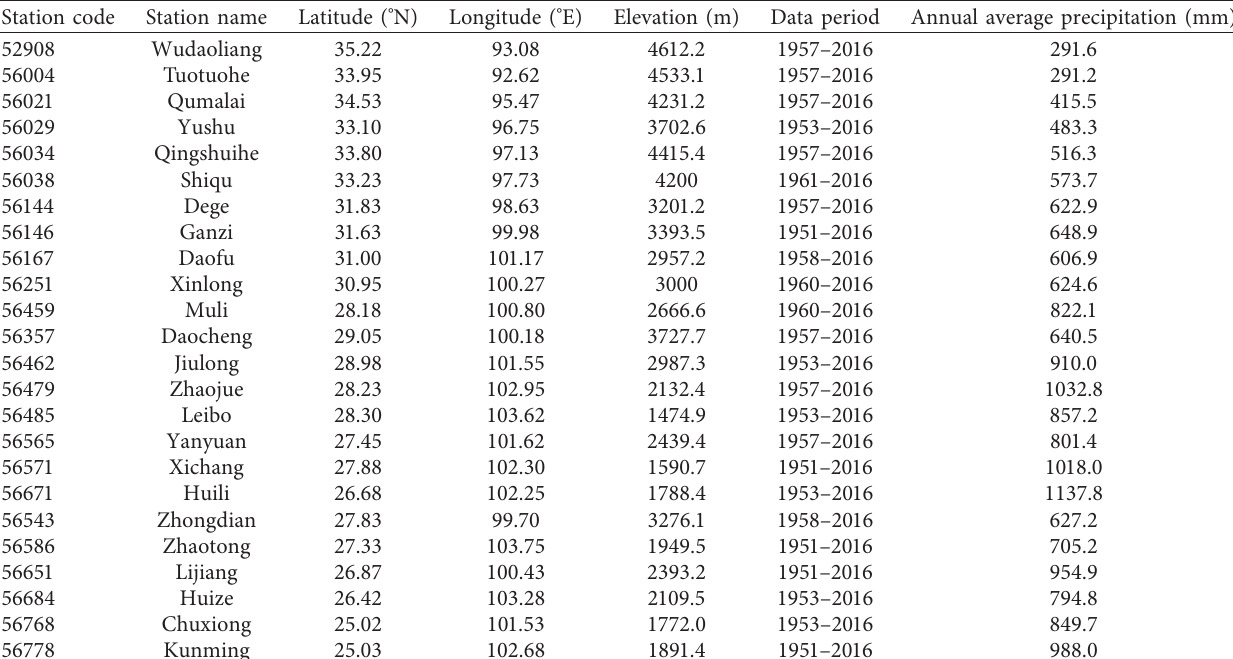
Table 1: List of the selected meteorological stations.